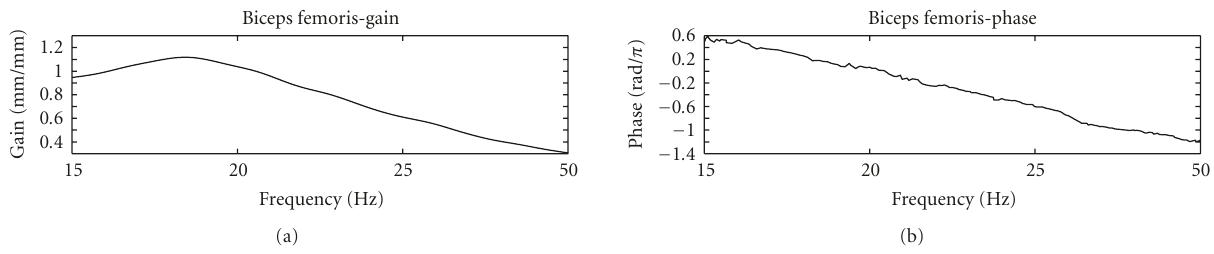
Figure 8: An example of BF frequency response—(a) amplitude and (b) phase—over frequency with respect to position P1.